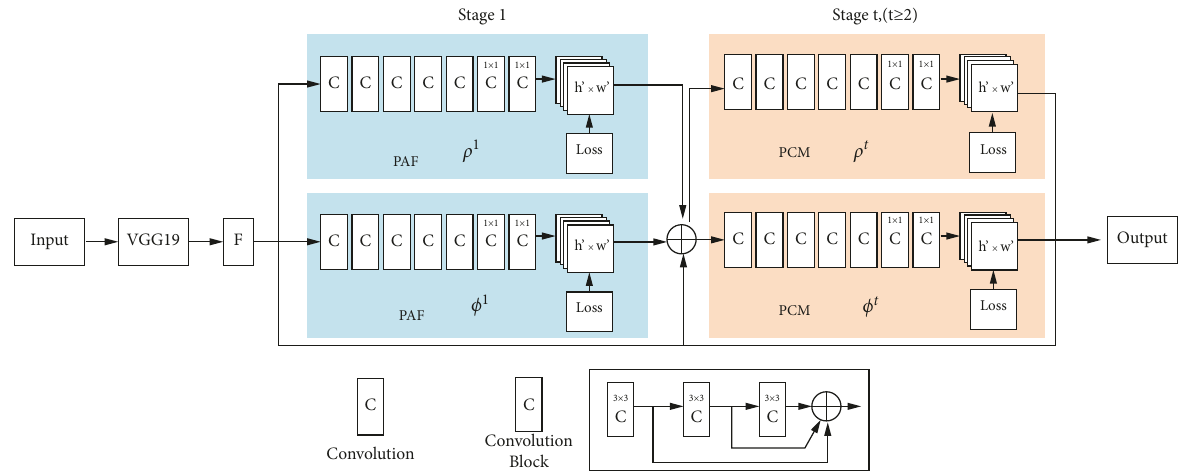
Figure 4: Athletics action estimation